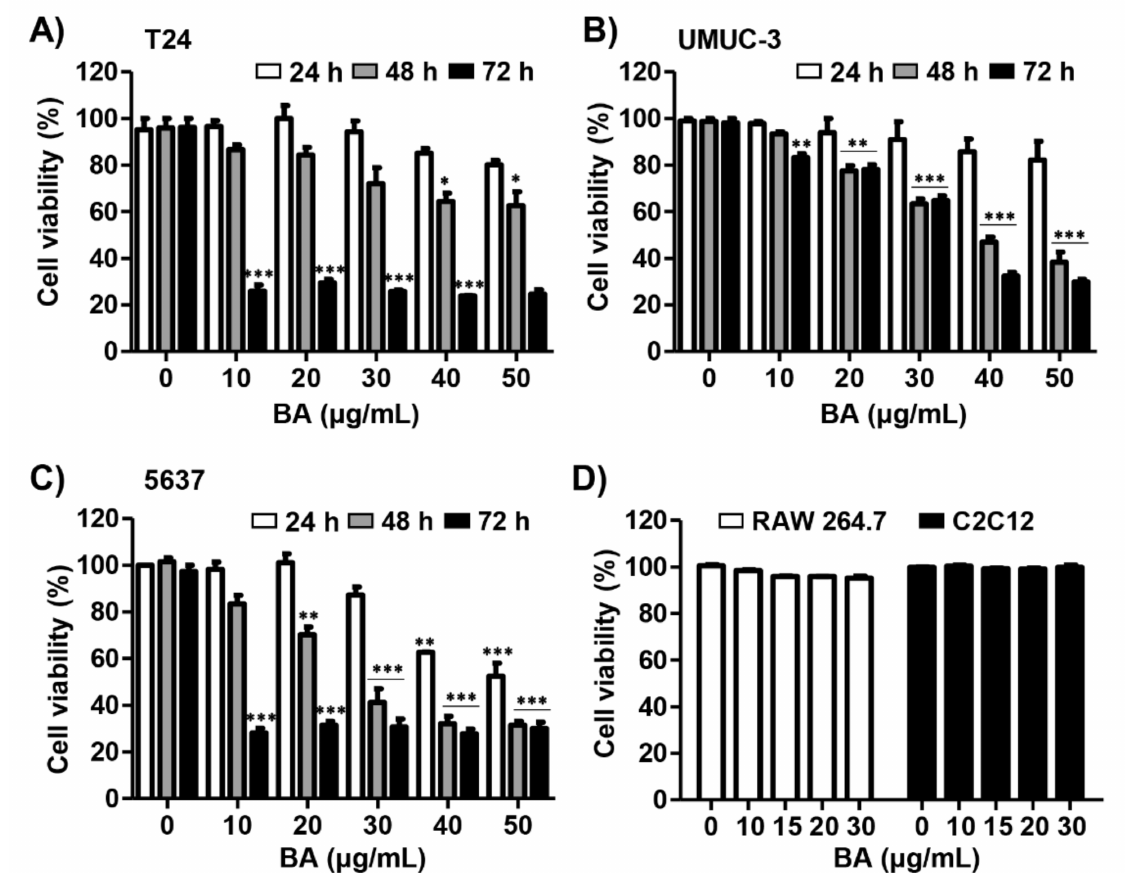
Figure 1. Betulinic acid (BA) inhibits cell viability in human bladder cancer cells. ( A – C ) Three bladder cancer cell lines T24, UMUC-3, and 5637 were treated with the indicated concentrations of BA for 24, 48, and 72 h. Cell viability was measured by the Cell Counting Kit-8 (CCK-8) assay. The data are expressed as mean ± standard deviation (SD) of three independent experiments. * p < 0.05, ** p < 0.01, and *** p < 0.001 vs. untreated control group. ( D ) RAW 264.7 macrophages and C2C12 myoblasts were treated with BA (0, 15, and 30 µ g/mL) for 48 h. Cell viability was measured by the CCK-8 assay and is presented as the mean ± SD ( n =